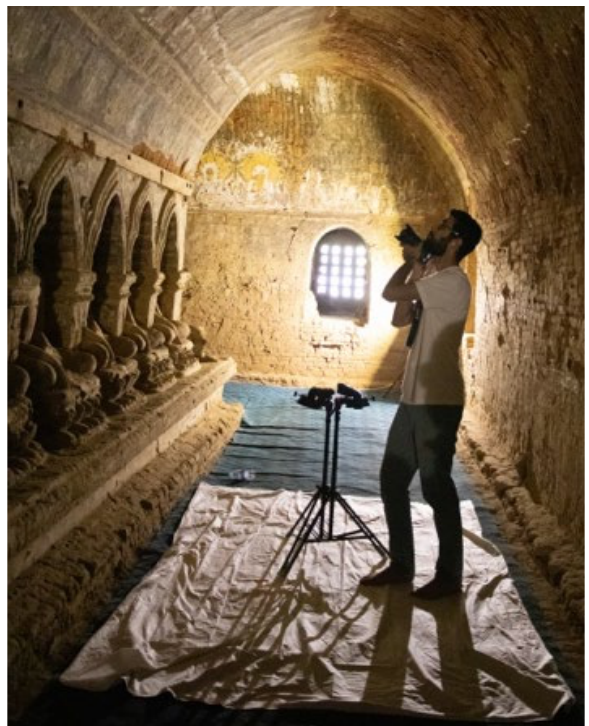
Figure 6. The 2020 capture of the interior of Myin-pya-gu by CIMS using speedlights reflected off a white sheet for even lighting in the orthophotos (Credit: Carleton Immersive Media Studio; Carleton University. © J. Paul Getty Trust).